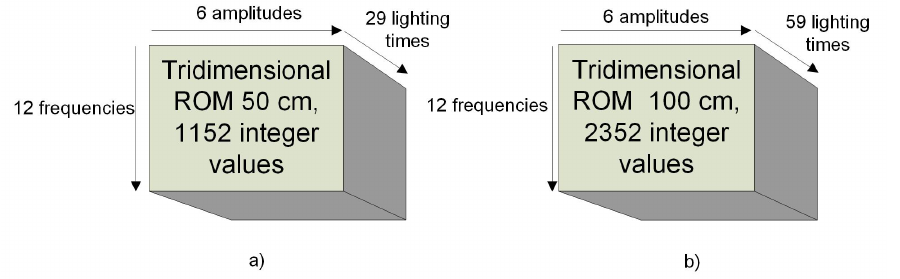
Figure 12. Storage of LED lighting times. Tri-dimensional ROMs for the SPSS tests of ( a ) 50 cm and ( b ) 100